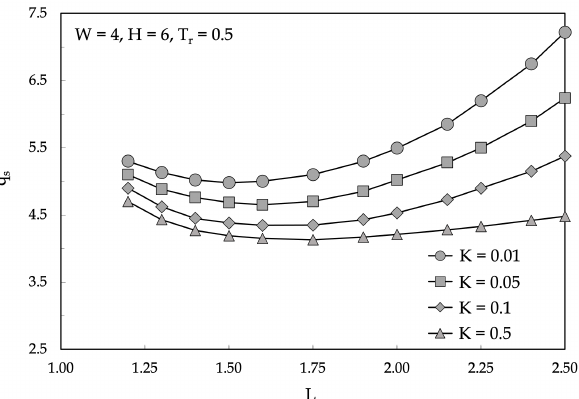
Figure 12. Distributions of the dimensionless heat loss from the supply pipe q s versus L using K as a parameter.